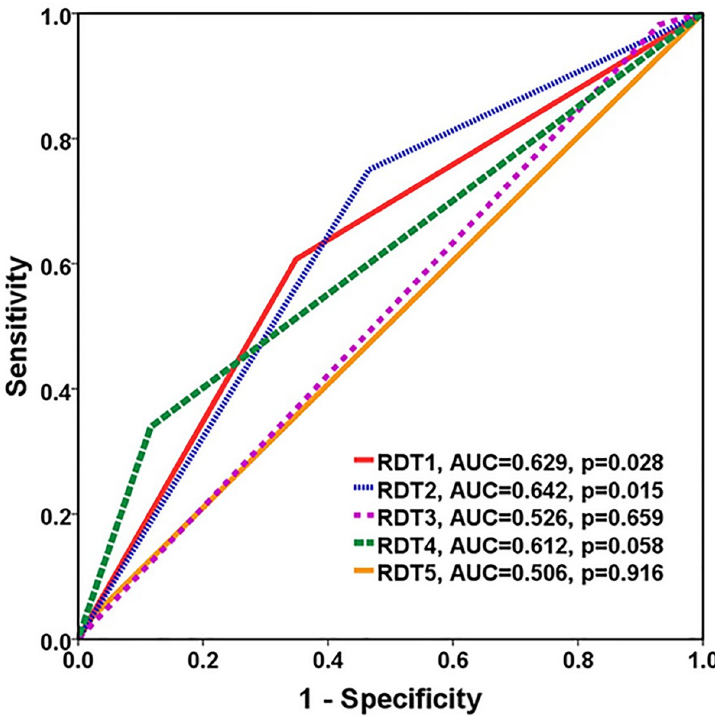
Fig 2. AUC ROC curve comparison against the reference standard method for predicting